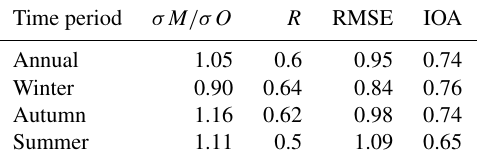
Figure 7. Annually averaged NO 2 concentrations (µgm − 3 ) from the EPISODE model over the Grenland domain at 100m × 100m horizontal resolution. The concentrations are derived from the re- ceptor point concentrations and then re-gridded onto a 100m grid. The colour scale shows the range in annual mean NO 2 concentra- tions between 0 and 40µgm − 3 . The black triangles indicate the lo- cations of the air quality observation stations (Table 7). The dark shaded areas represent the sea, lakes, and rivers. The black lines are roads. © OpenStreetMap contributors 2019. Distributed under a Creative Commons BY-SA License.